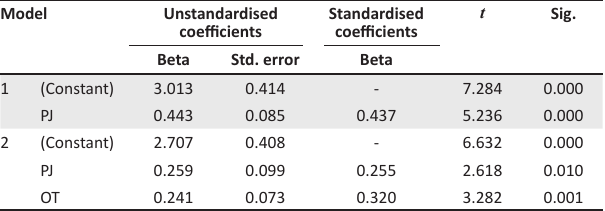
TABLE 6: Hierarchical regression analysis (dependent variable: person– organisation fit; predictors: procedural justice, organisational trust).